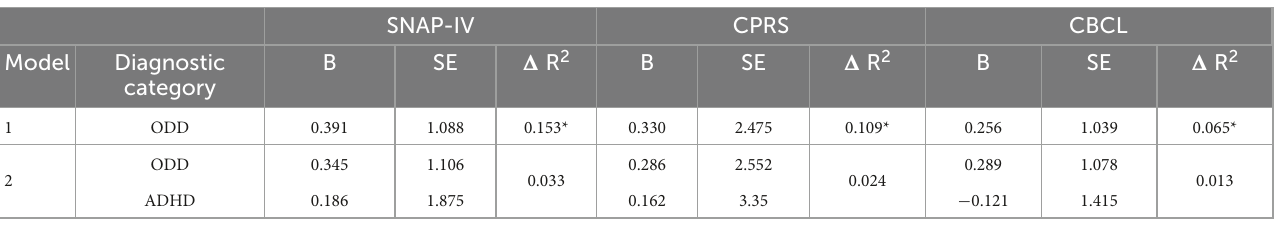
TABLE 1 Convergent and divergent validity of ODD and ADHD